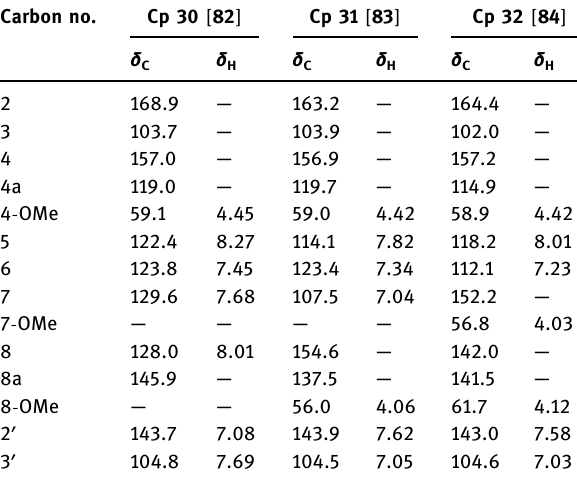
Table 8: 13 C and 1 H NMR chemical shift data ( δ , ppm ) of alkaloid isolated from genus Casimiroa Carbon no.